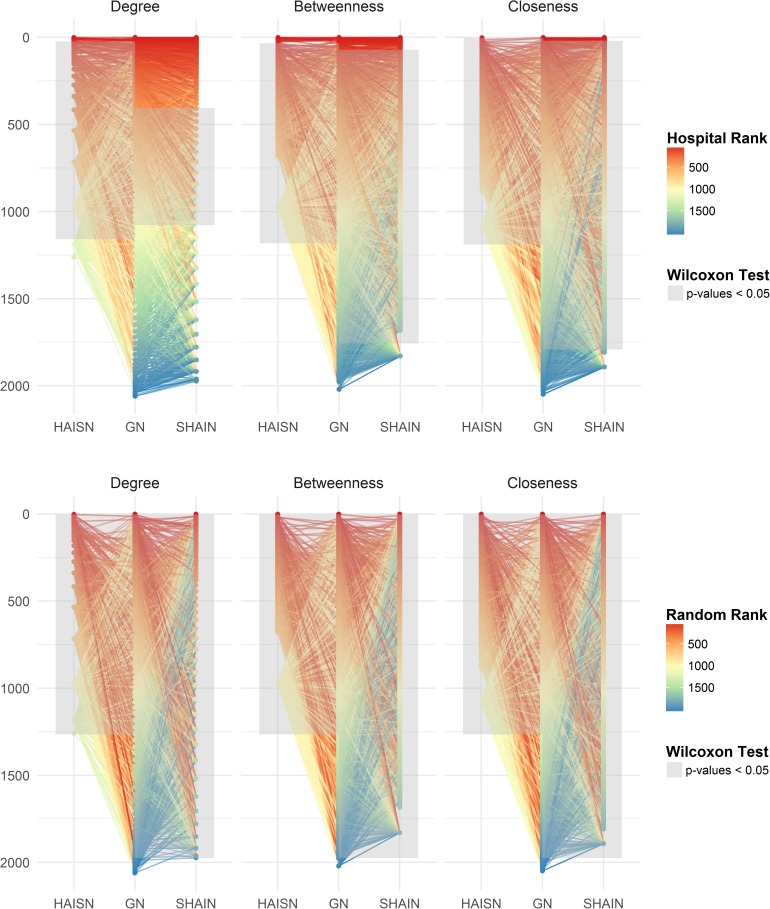
Hospital rankings by degree, betweenness, and closeness across the networks.Hospitals in the HAI-specific network (HAISN) (n = 1266), suspected-HAI network (SHAIN) (n = 1975), and general network (GN) (n = 2063) are displayed vertically and plotted against their ranking by degree, betweenness, and closeness centrality measures (top row). Only the hospitals shared between the HAISN and GN or the SHAIN and GN were linked. The color gradient refers to the hospital ranking for each centrality measure and the line colors correspond to the rankings of the hospitals in the GN. We tested the differences in rankings by Wilcoxon rank sum test of an increasing subset of hospital degrees starting from the highest rank and adding each consecutive rank and retesting. The grey area represents the range where the HAISN or SHAIN differed from the general network hospital rankings. We chose rankings at random for the hospital degrees, betweenness, and closeness centrality measures for comparison (bottom row). All random rankings were statistically different across the centrality measures between the HAISN and GN and the SHAIN and GN shared hospitals.